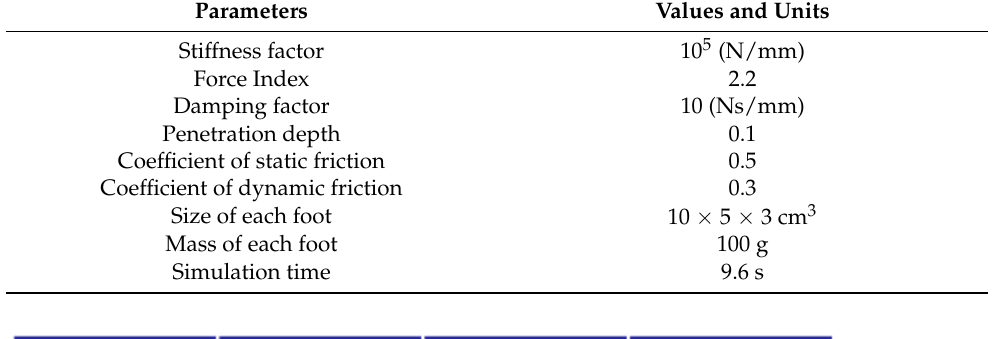
Table 1. Kinetic scaling parameters in Adams.